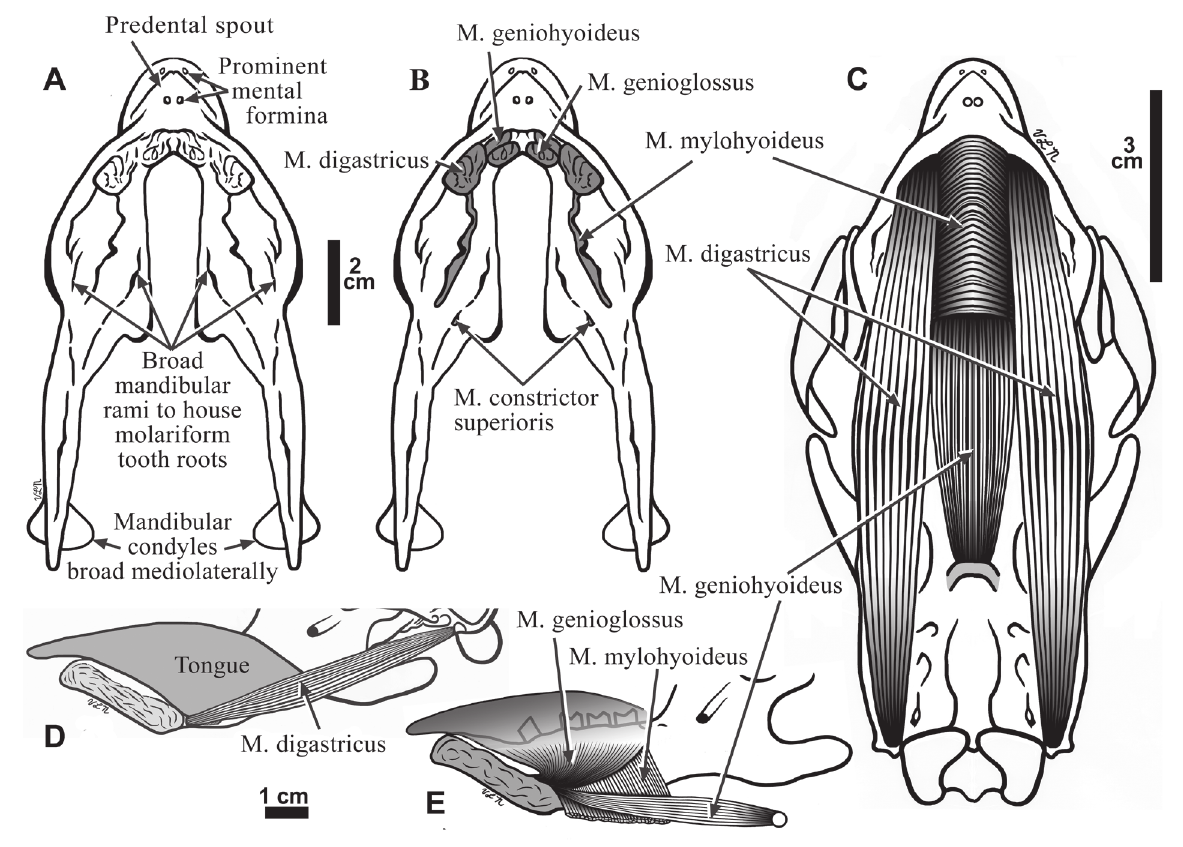
Figure 7. Ventral views of the mandible of Hapalops showing suprahyoid muscle scars ( A ) and with areas of muscle origins shaded ( B ); 2 cm scale. These muscles are reconstructed in ventral view ( C ) and lateral view ( D , E ). In D and E , the tongue position has been estimated to show it relative to that of the oral musculature; 1 cm